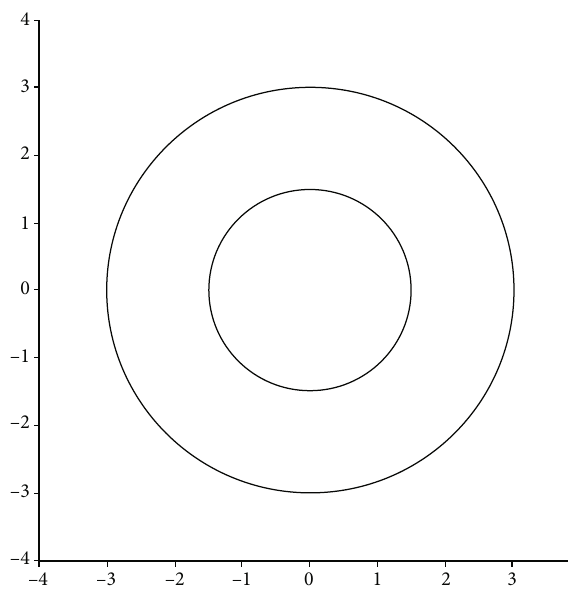
Figure 8: The set in Counterexample